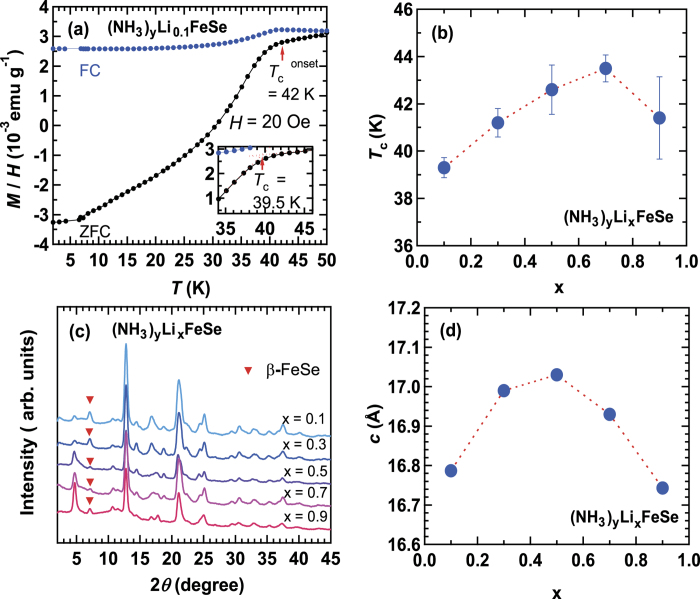
(a) M / H vs. T plots of (NH3)yLi0.1FeSe in ZFC and FC modes (H = 20 Oe). Inset in (a) shows the method used to determine Tc. (b) Tc
vs. x plot in (NH3)yLixFeSe. (c) XRD patterns of (NH3)yLixFeSe at x = 0.1 to 0.9. (d) c vs. x plots in (NH3)yLixFeSe; x is nominal value.